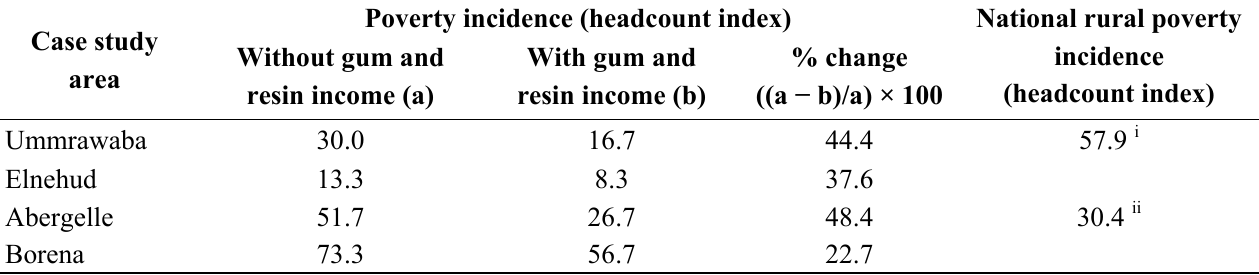
Table 4. Poverty incidence (headcount index) and the effect of gum and resin income in reducing poverty incidence across the case study areas.